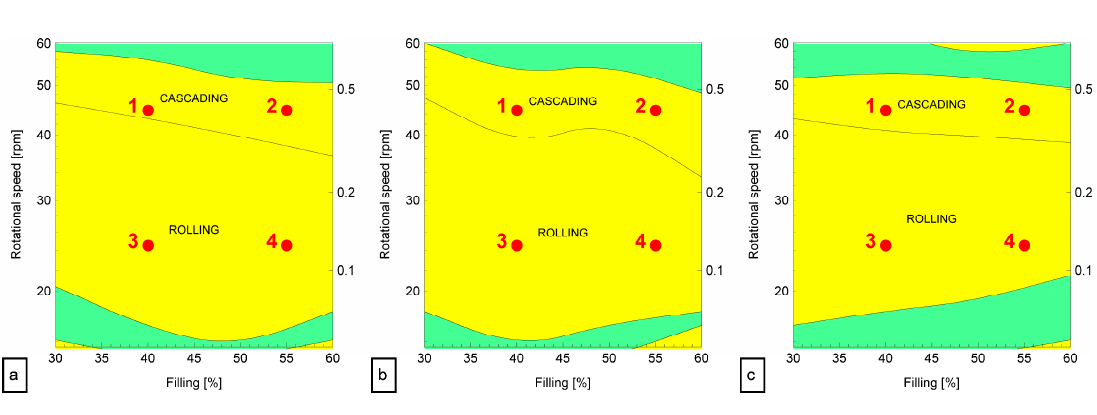
Figure 7. Barrel finishing (BF) parameter sets for charge 1 ( a ), charge 2 ( b ), and charge 3 ( c ) within the rolling and cascading regimes.